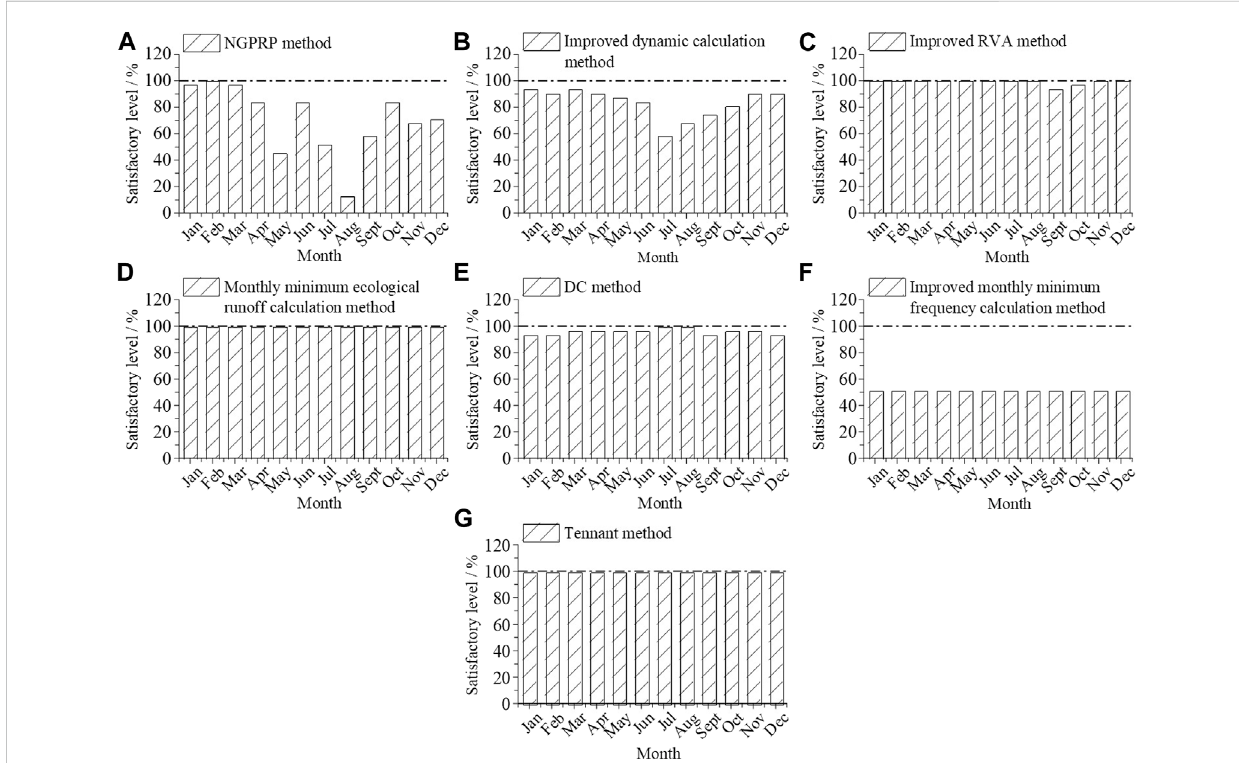
FIGURE 5 Monthly ecological fl ow satisfactory level within the year. (A) shows the Satisfactory level of ecological fl ow calculated according to the NGPRP method. (B) shows the Satisfactory level of ecological fl ow values calculated according to the Improved dynamic calculation method. (C) shows the Satisfactory level of ecological fl ows calculated according to the Improved RVA method. (D) shows the Satisfactory level of ecological fl ows calculated according to the Monthly minimum ecological runoff calculation method. (E) shows the Satisfactory level of ecological fl ows calculated according to the DC method. (F) shows the Satisfactory level of ecological fl ows based on the Improved monthly minimum frequency calculation method. (G) shows the Satisfactory level of the ecological fl ow calculated according to Tennant ’ s